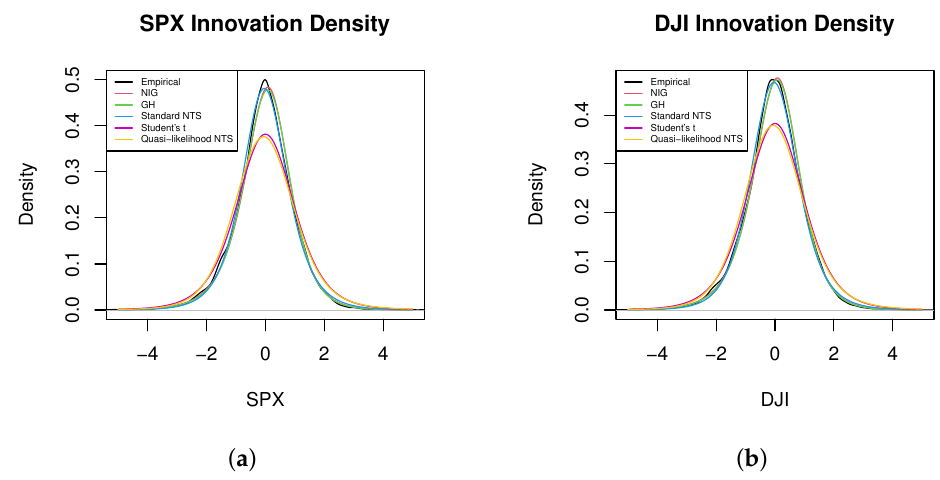
Figure 6. Density plot for the innovations of the ( a ) S&P 500 index and ( b ) Dow Jones index. Magnify figures easier to